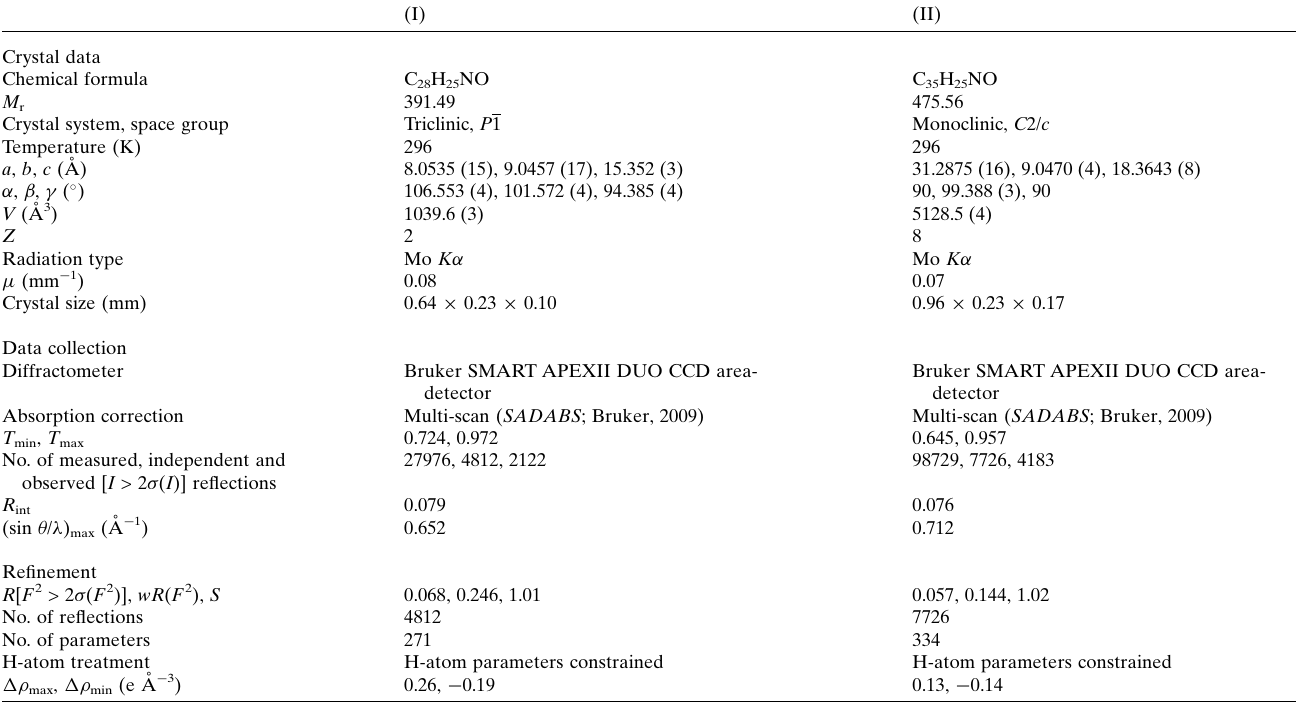
Table 3 Experimental details.